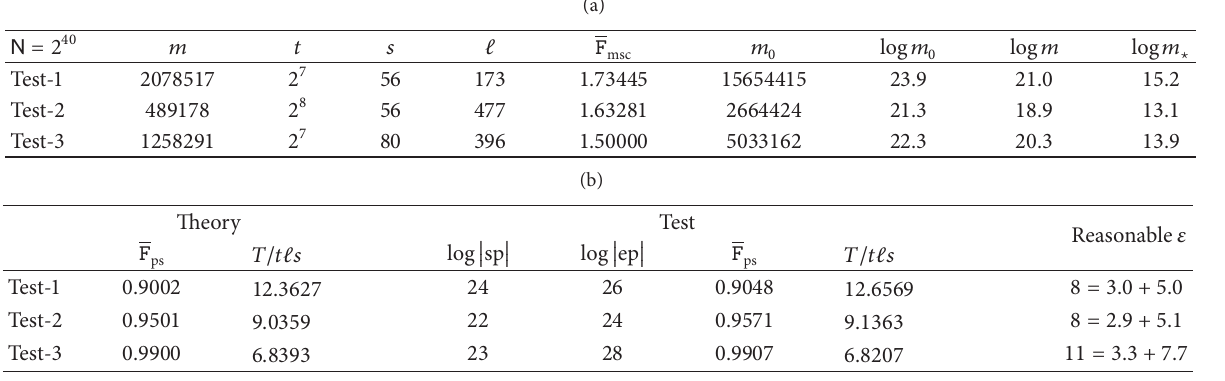
Table 4: Experimental verification of the online time complexity as given by